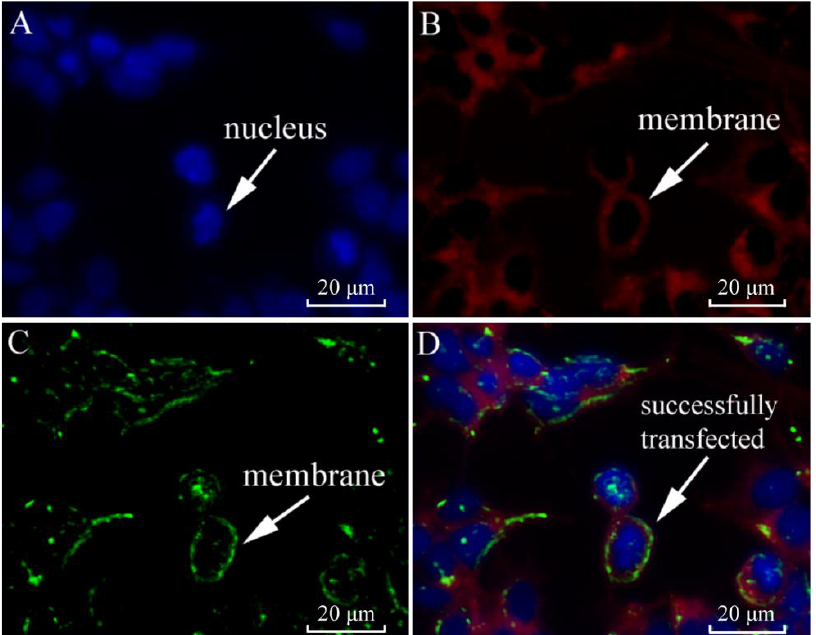
Figure 4. Subcellular localization of SjILPR . ( A ) Nucleus of HEK293T cells were stained with DAPI (shown in blue). ( B ) Plasma membranes of cells were stained with DiI (shown in red). ( C ) SjILPR -EGFP fusion protein was shown in green. ( D ) Localization of SjILPR was depicted in yellow. The nucleus and plasma membrane are indicated with white arrows in ( A – D ).